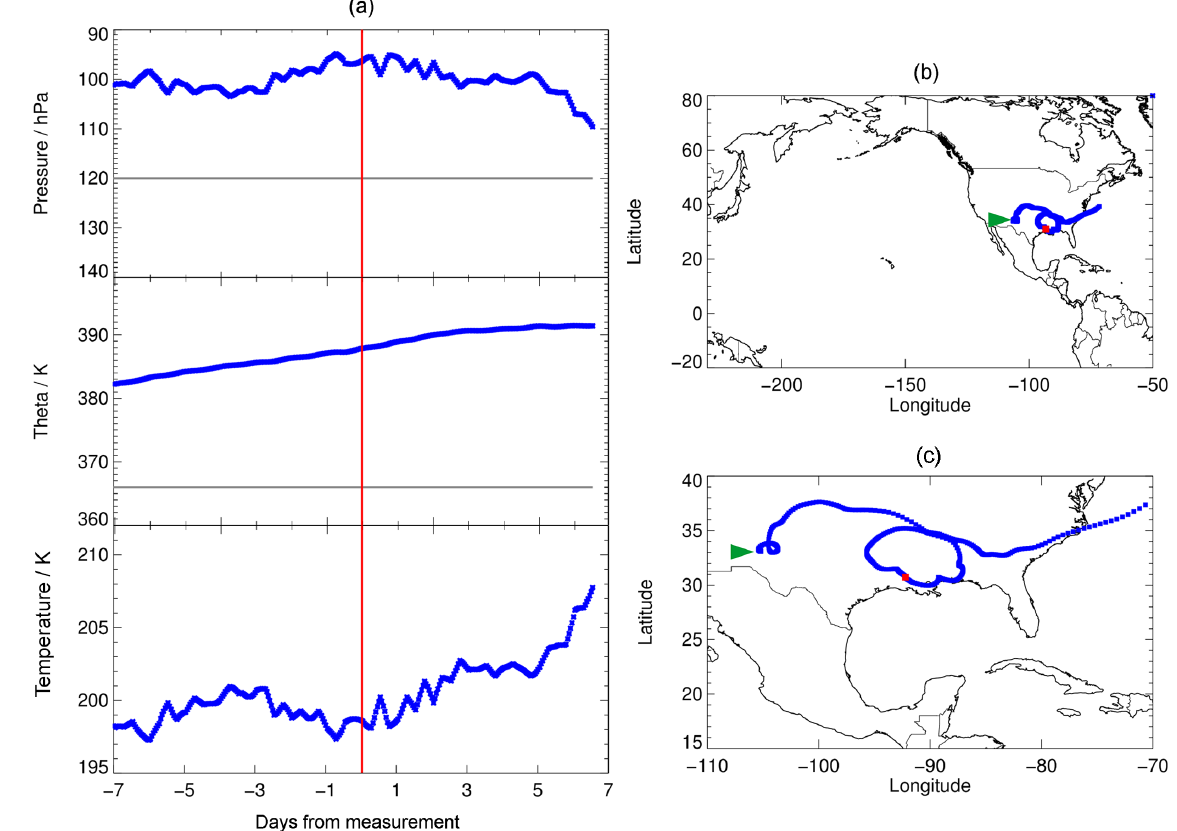
Figure 1. Pressure, potential temperature, temperature and location of the selected 7d trajectories (forward and backward) calculated based on measurements with enhanced water vapour during the SEAC 4 RS aircraft campaign. In (a) , the grey line marks the approximate tropopause altitude, deduced from the temperature profile measured during the flight. The red line in (a) marks the time of measurement and red squares in (b, c) mark the location of the measurement. Panel (c) exhibits a close-up of (b) and the beginning of the backward trajectory (1 August) is marked by a green